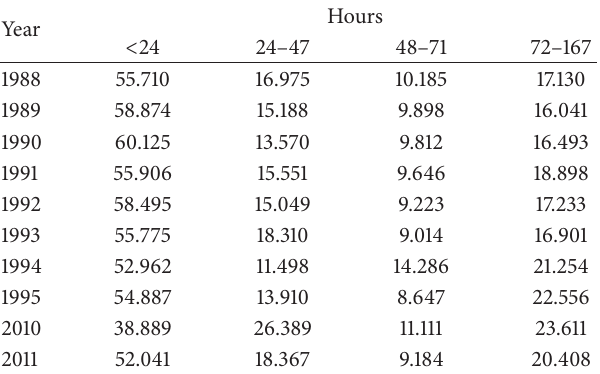
Table 4: Percentage of early neonatal deaths by hours of survival after